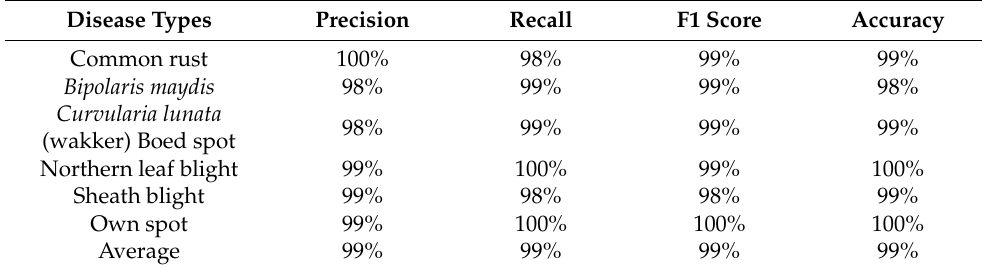
Table 6. The recognition accuracy of the model.